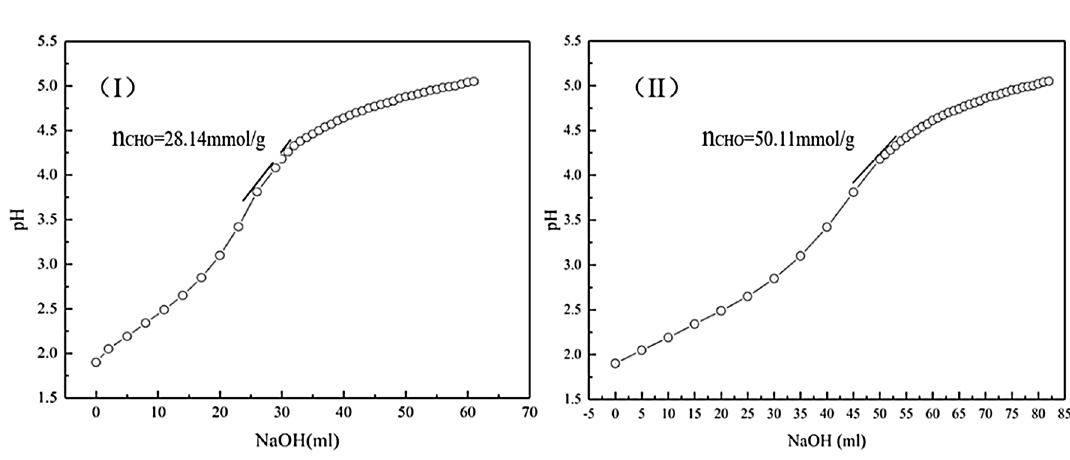
Figure 2. Aldehyde content of OSu ( I ) and openSu ( II